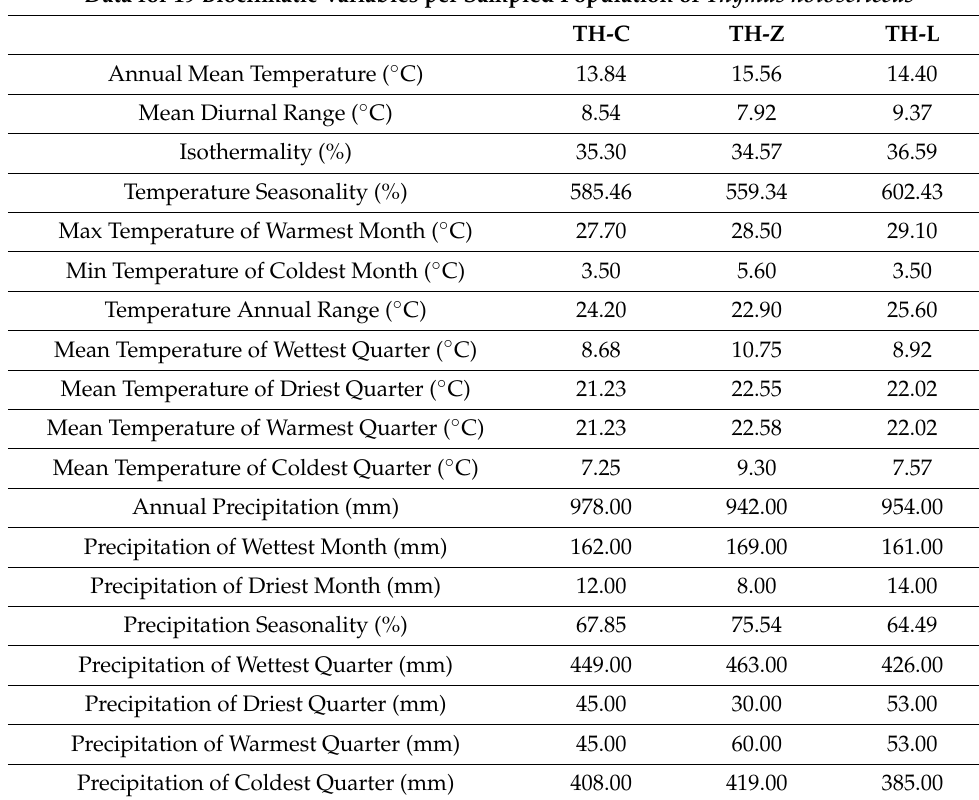
Table 2. Climate data (19 bioclimatic variables and units) for the three sampled areas of Thymus holocericeus in Cephalonia (TH-C), Zakynthos (TH-Z), and Lefkada (TH-L) islands, Ionian Sea, Greece derived from WorldClim version